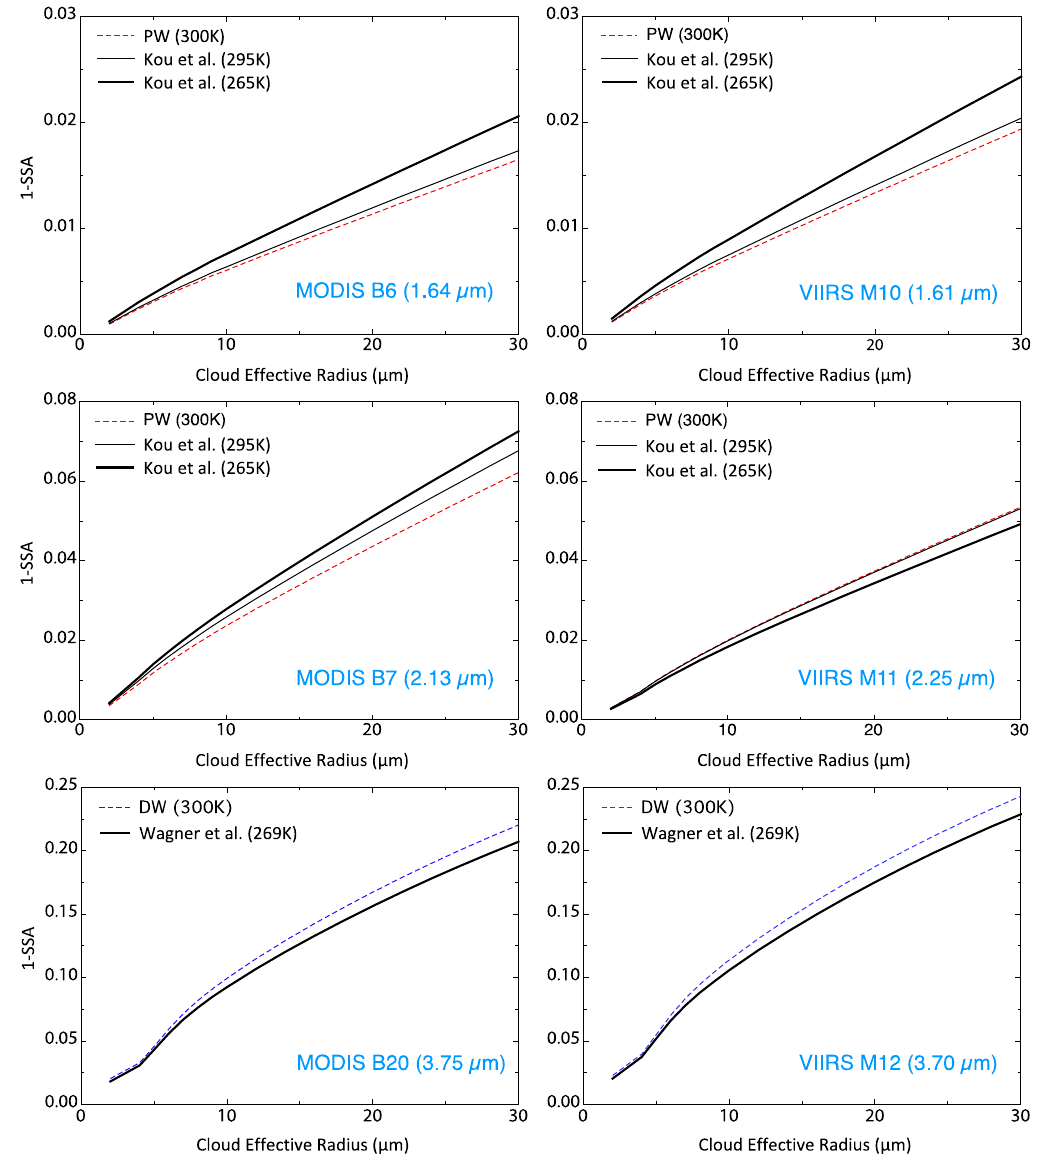
Figure 3. MODIS ( left column) and VIIRS ( right column) SWIR and MWIR channels droplet co-albedo (1-SSA) versus effective radius for the index of refraction datasets used in the retrieval sensitivity studies of Section 3.2. PW and DW represent the datasets of Palmer and Williams and Downing and Williams , respectively, used in the MODIS standard cloud optical product. The thick solid line represents the dataset adopted for the MODIS/VIIRS cloud continuity product.